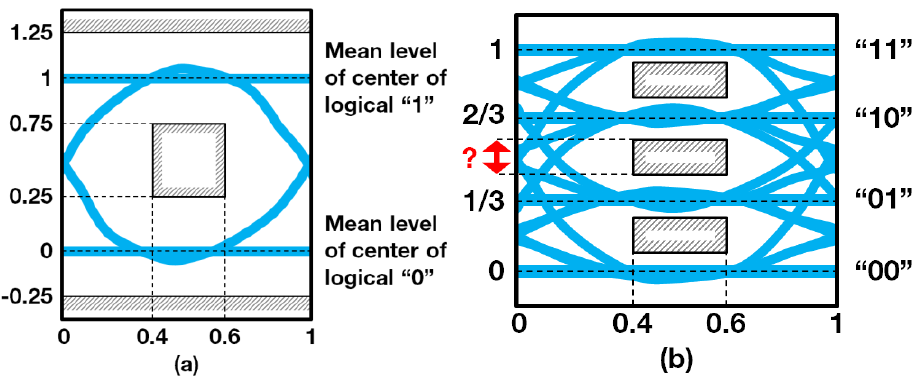
Figure 3. Mask of the eye diagram for OLT transmitter ( a ) and proposition for PAM ( b ).